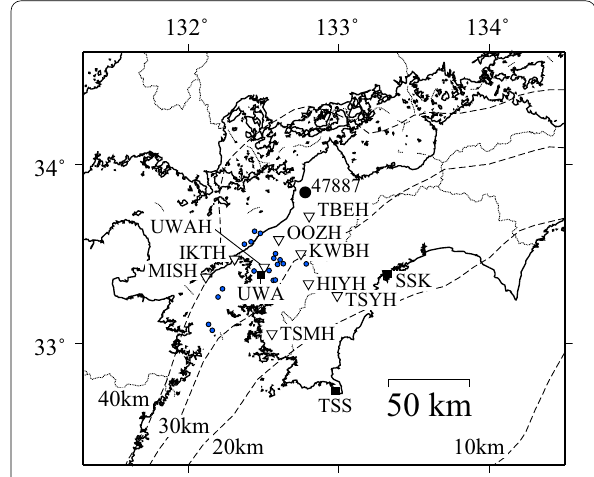
Fig. 15 Epicentral distribution of LFTs (dots) in the Shikoku region during 23–27 October 2016 (NIED catalog). Also shown are locations of strain observation stations (squares), Hi-net (tilt data) stations (triangles), and Matsuyama weather station 47887 (circle). Map region corresponds to Area C in Fig. 1. Dashed contours indicate the depth of the Philippine Sea plate